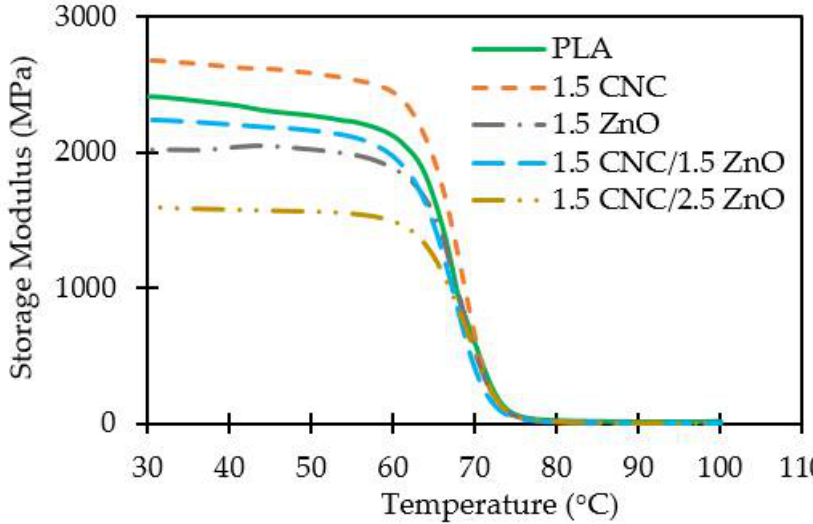
Figure 4. Representative curve of storage modulus vs. temperature PLA and corresponding nano-